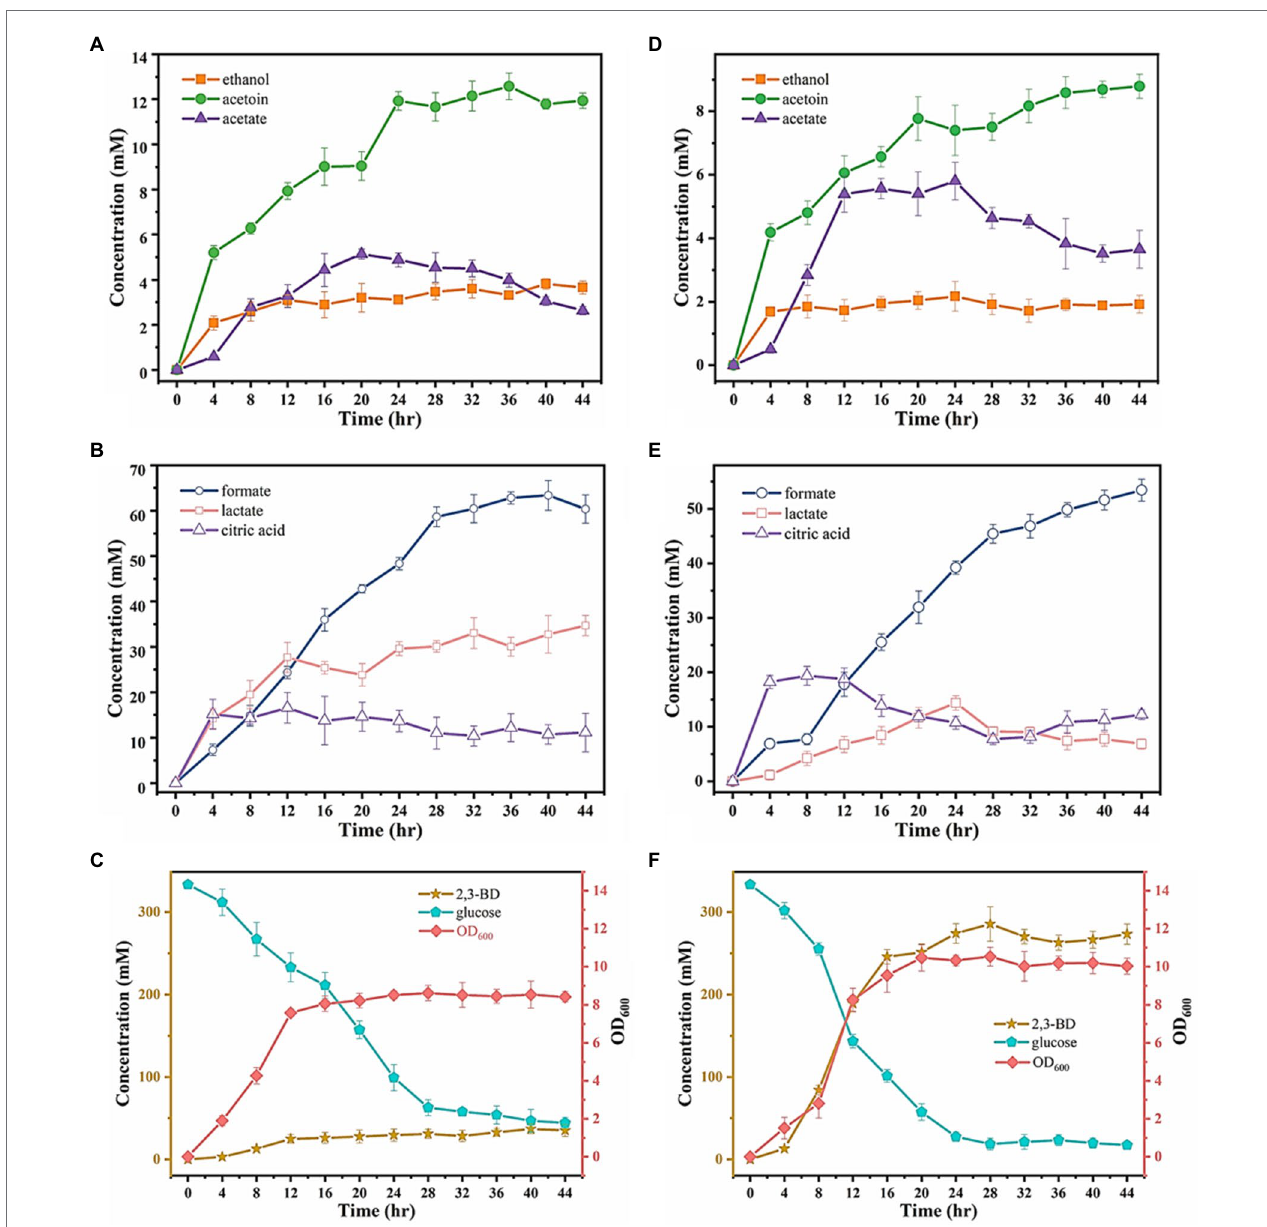
FIGURE 6 | Substrate consumption and produced metabolites after 44 h of fermentation for the wild-type strain IAM1183 and the best mutant Ea-2 in a 5-L fermenter. (A) Metabolite concentrations of acetate, acetoin, and ethanol in the culture supernatant IAM1183. (B) Metabolite concentrations of formate, lactate, and citric acid in the culture supernatant of IAM1183. (C) OD 600 , glucose consumption, and concentration of 2,3-BD in the culture supernatant of IAM1183. (D) Metabolite concentrations of acetate, acetoin, and ethanol in the culture supernatant of Ea-2. (E) Metabolite concentrations of formate, lactate, and citric acid in the culture supernatant of Ea-2. (F) OD 600 , glucose consumption, and concentration of 2,3-BD in the culture supernatant of Ea-2. Symbols represent acetoin (green circles), acetate (dark purple triangles), ethanol (orange squares), formate (blue circles), lactate (pink squares), citric acid (light purple triangles), optical density (pink diamonds), consumed glucose (blue pentagons), 2,3-BD (orange